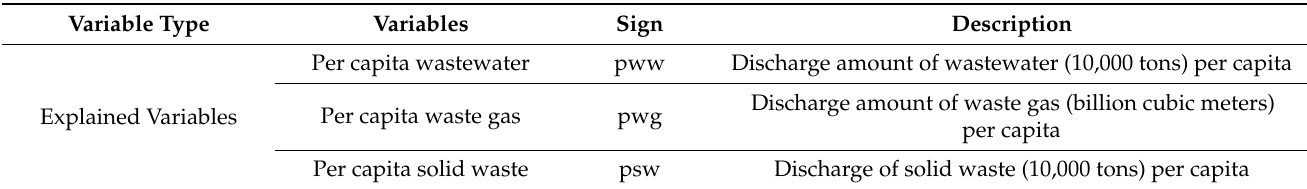
Table 2. Classification and descriptions of